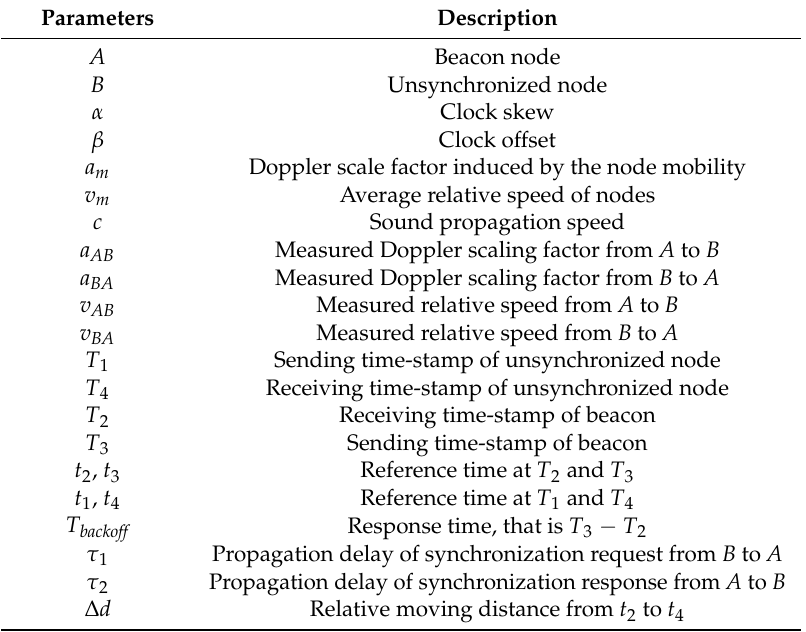
Table 1. Parameter